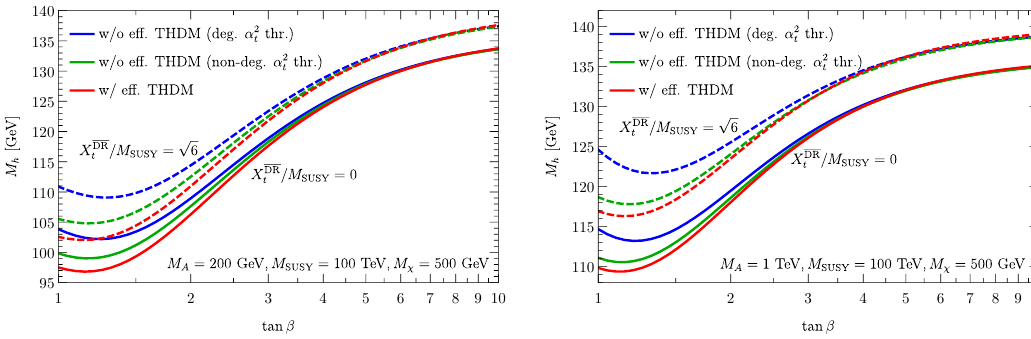
p Figure 4 . M h as a function of tan (cid:12) for X DR =M SUSY = 0 (solid) and X DR =M SUSY = 6 (dashed). t t Left: M A = 200 GeV. Right: M A = 1 TeV. The results of FeynHiggs without e(cid:11)ective THDM | using the degenerate O ( (cid:11) 2 ) threshold correction (blue) and using the non-degenerate O ( (cid:11) 2 ) thresh- t t old correction (green) | are compared with the results of FeynHiggs with e(cid:11)ective THDM (red).